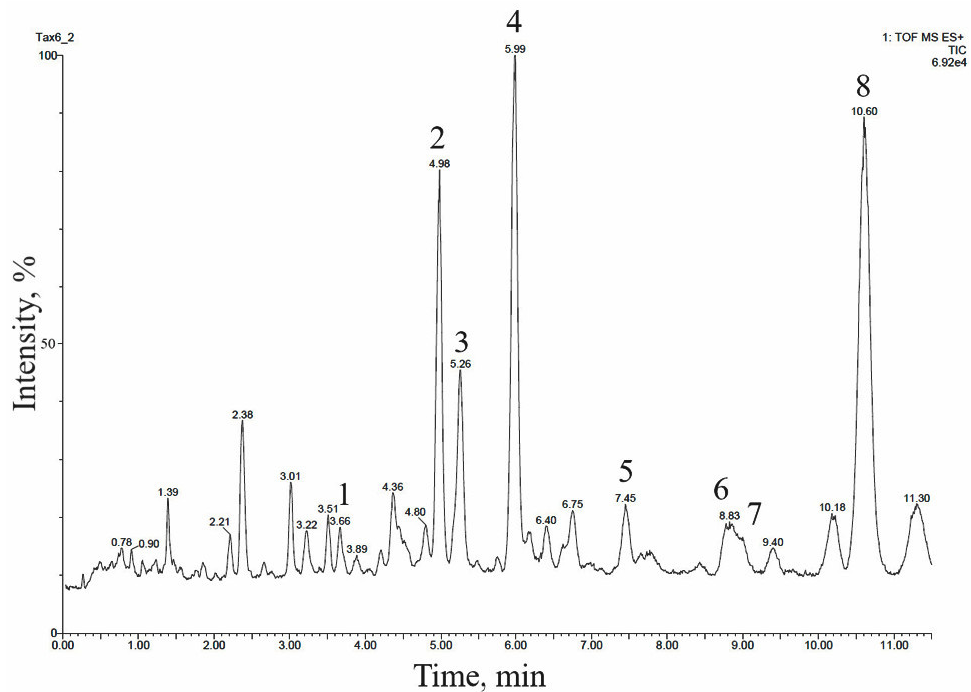
Figure 3. UPLC–ESI-MS chromatogram (total ion current, positive ion mode) of an alcohol extract from the biomass of T. baccata cell suspension culture ( Tb-msu /B5-NB-Car line grown in a 20-L bioreactor). The description of peaks 1 – 8 is given in Table 4.